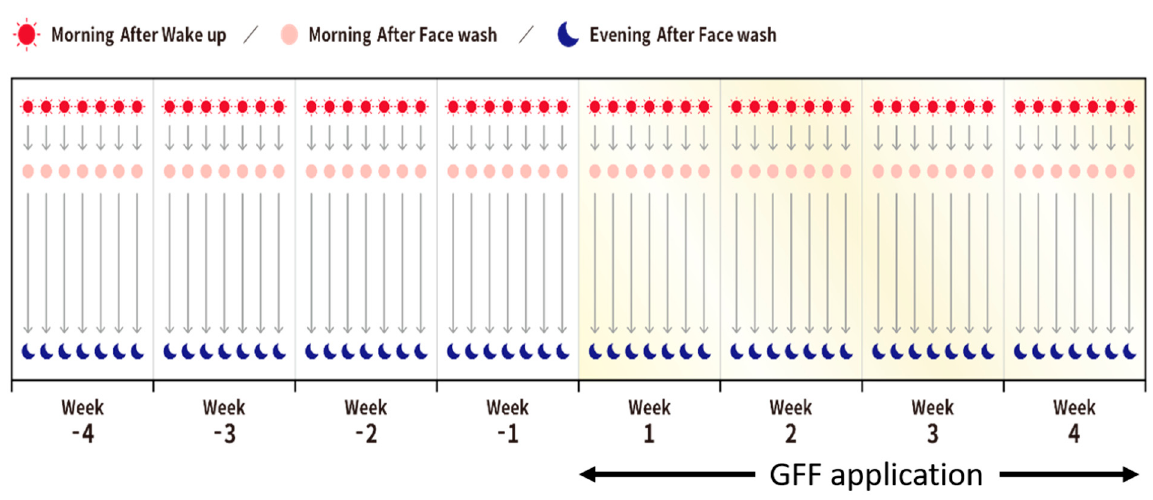
Figure 3. Study protocol in Studies 1 and 2. All subjects took their facial images using eMR Pro three times a day: during the morning after wake-up, during the morning after face wash and during the evening after face wash. Baseline data were collected from week -4 to week -1. Then, the GFF skin care formula was used from week 1 to week 4.